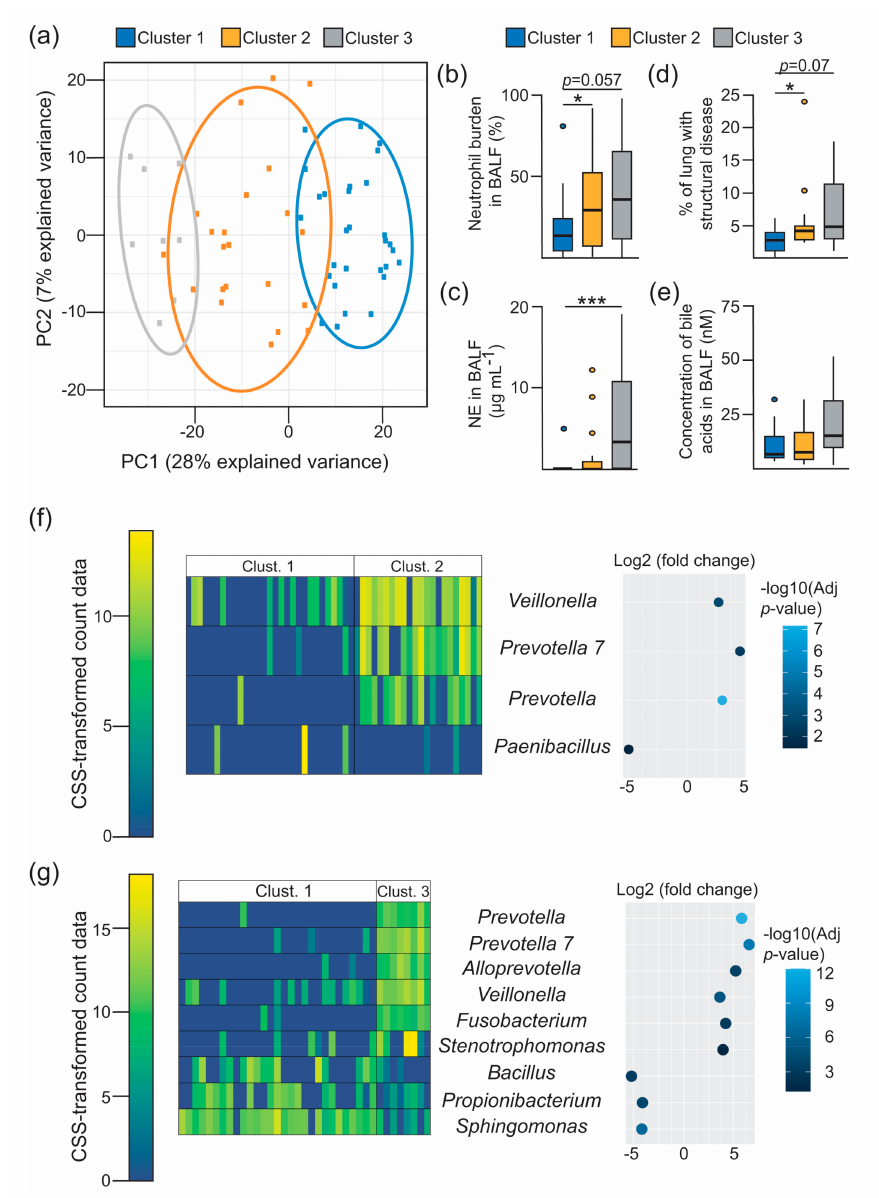
Figure 2. Inflammatory surrogates in BALF are linked to specific microbial assemblages. ( a ) Principal component analysis decomposition of the OTU counts transformed using the cumulative sum scaling (CSS) normalization method. Mean-centering was performed to better represent the direction of variability across group centroids. BALF-associated taxonomic profiles are projected onto the first two components of the model. Dots represent each BALF specimens, which are coloured accordingly with the Gaussian Mixture Model-based cluster membership (cluster 1, n = 29 BALF specimens; cluster 2, n = 22; cluster 3, n = 8). Ellipses represent the 86% confidence region. ( b – e ) Boxplots showing between-cluster comparisons of the indicated markers of disease progression ( b – d ) and bile acid concentration ( e ) in BALF. Multiple comparisons were assessed for significance in the context of Dunnett’s test. *, p < 0.05; ***, p < 0.001. ( f , g ) Heatmaps (left) and bivariate dot plot (right) representing the CSS-normalised count data and the fold change (log2 scale) for the selected OTUs between the indicated clusters (Clust.), respectively. Di ff erentially abundant features between clusters were estimated from a zero-inflated log-normal model as implemented in the fitFeatureModel method [20]. Features with a log2 (fold change) > | 2 | and an FDR-corrected (adjusted p -value) p -value < 0.05 are depicted. Colour legend for the heatmap (left), and the dot plot (right), represent the CSS-transformed count data and the –log10 (adjusted p -value) respectively. Each column in the heatmaps represents the profiles of individual BALF samples, and rows represent the indicated